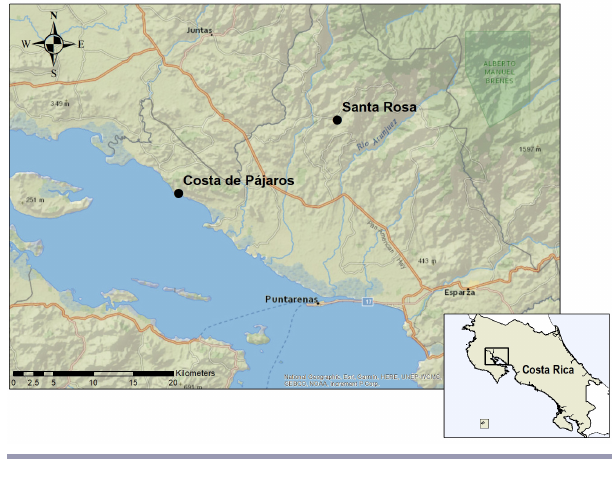
Fig. 1 . Study sites in the Central Pacific region of Costa Rica. National Geographic Basemap credits: National Geographic, Esri, Garmin, HERE, UNEP-WCMC, USGS, NASA, ESA, METI, NRCAN, GEBCO, NOAA, increment P Corp.